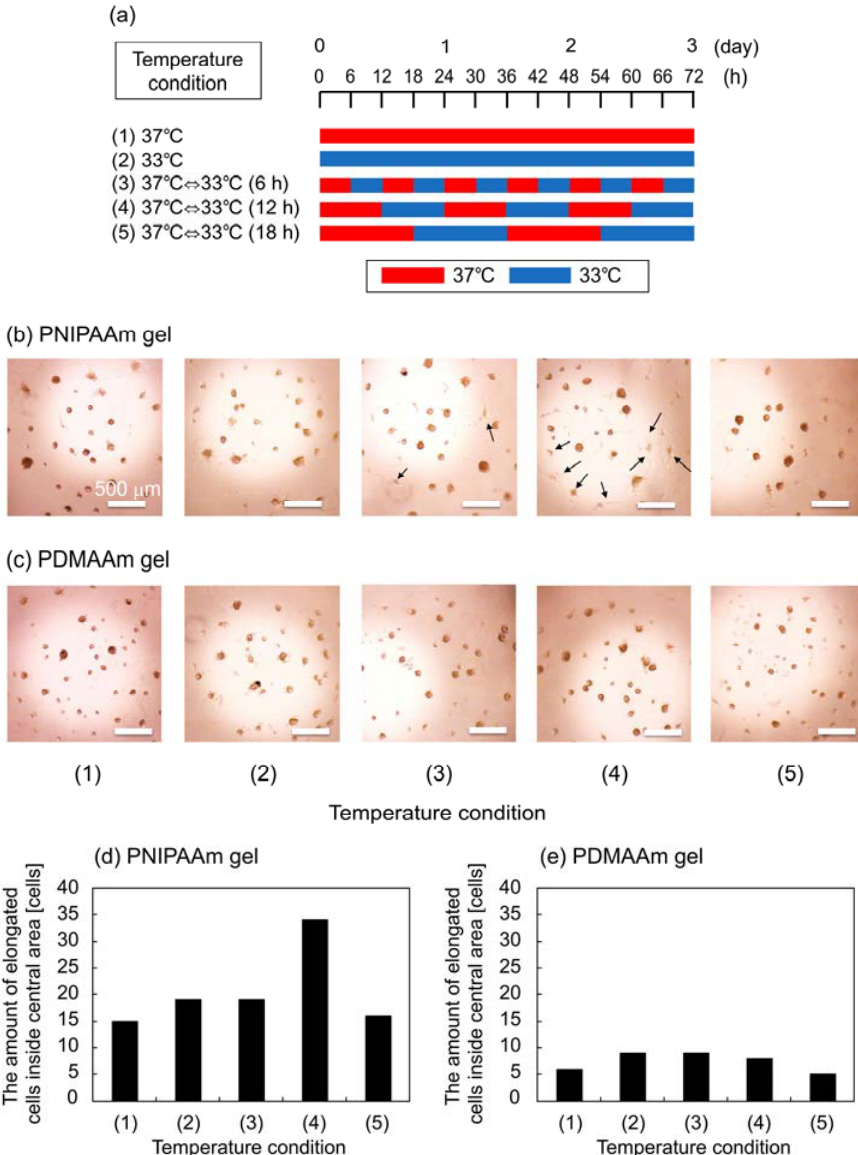
Figure 4. ( a ) Schematic explanation of temperature conditions for the cell culture experiments. Phase ‐ contrast images of hbmMSCs on ( b ) PNIPAAm gel and ( c ) PDMAAm gel after three days in culture using AIM as cell culture media. The amount of elongated cells inside central area of ( d ) PNIPAAm gel and ( e ) PDMAAm gel after three days in culture using AIM as cell culture media. The arrows in the panel ( b ) shows elongated